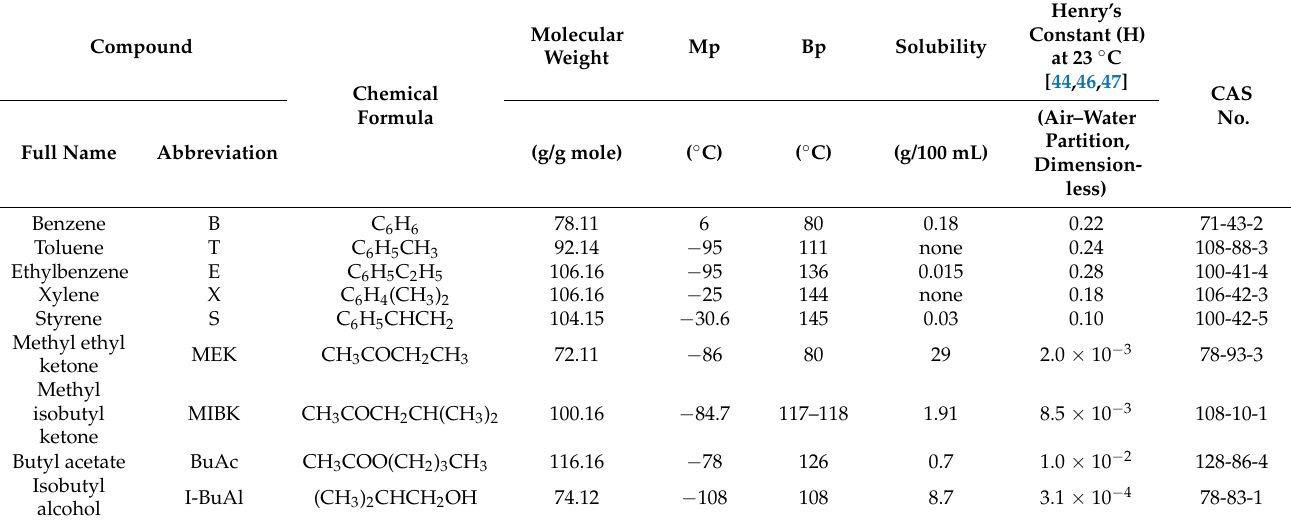
Table 2. Information of target VOCs in this study.